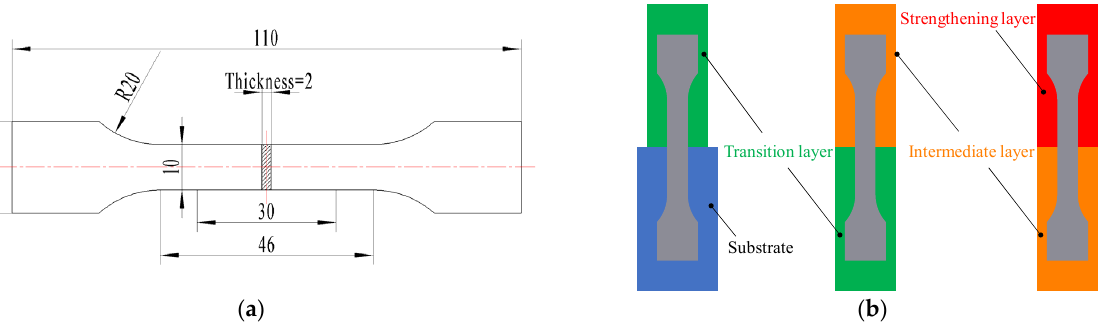
Figure 4. Size and sampling location of tensile test specimens. ( a ) Tensile specimen (unit: mm). ( b ) Sampling locations.